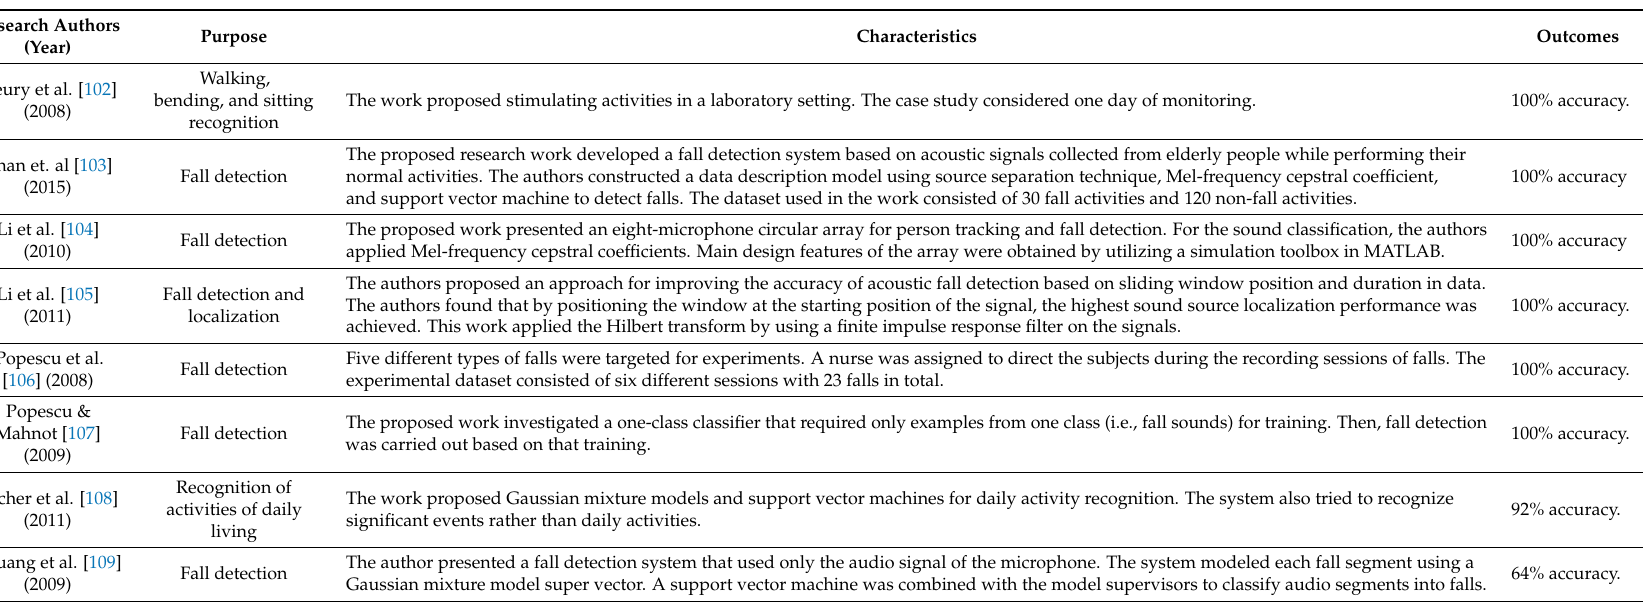
Table 5. Summary of research works that use sound sensor